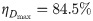
Adaptation of extinction simplex for pharmacokinetics.A: Exemplary DTG pharmacokinetics for 3days of 2mg oral DTG once daily. The blue line represents DTG plasma concentrations. The dashed orange line represents the function Dmax(t), which for a particular t returns the maximum DTG concentration achieved in any future time i.e Dmax(t) = max(D(u)) where u ∈ [t, ∞). The black horizontal dashed line marks the IC50 for DTG [38]. B: Instantaneous target-process inhibition (blue line) corresponding to the concentration-time profile in A. The orange line is the target-process efficacy profile for Dmax(t). The black horizontal dashed line marks η = 50%. C: Extinction simplex (viral infection state where the probability of viral extinction is greater than ε) corresponding to ηDmax=84.5%. D: The extinction simplex corresponding to η = 50%. Panels C&D show the state space with three dimensions corresponding to number of free viruses, early-infected T cells (T1) and late-stage infected T cells (T2). The color varies from bright yellow denoting certain extinction, to black denoting an extinction probability less than 0.0001. The region enclosed by green lines is the extinction simplex in absence of antivirals.